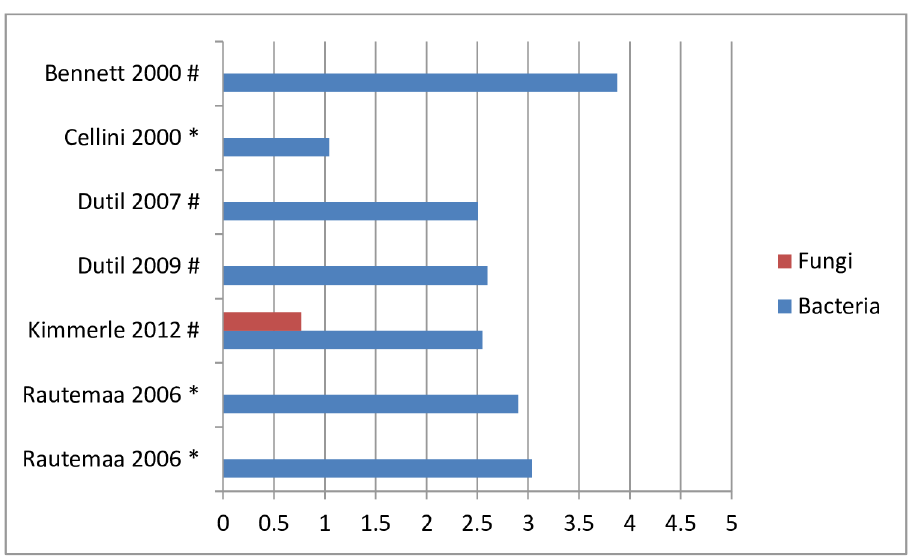
Fig 4. Bacterial or fungal loads in mean Log-10 CFU/m 3 in dental. * = passive samplingmethod; # active samplingmethod.